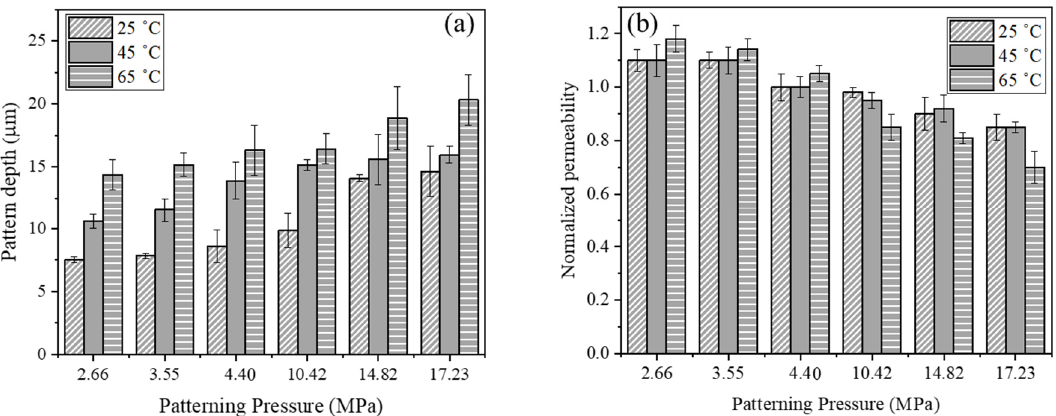
Figure 4. Effect of thermal embossing temperature and pressure on ( a ) average pattern feature depth and ( b ) normalized water permeability (relative to as-received membrane permeability). Feature depths were measured using LEXT with a 20× objective. Error bars represent ±1 ơ for three membrane samples.